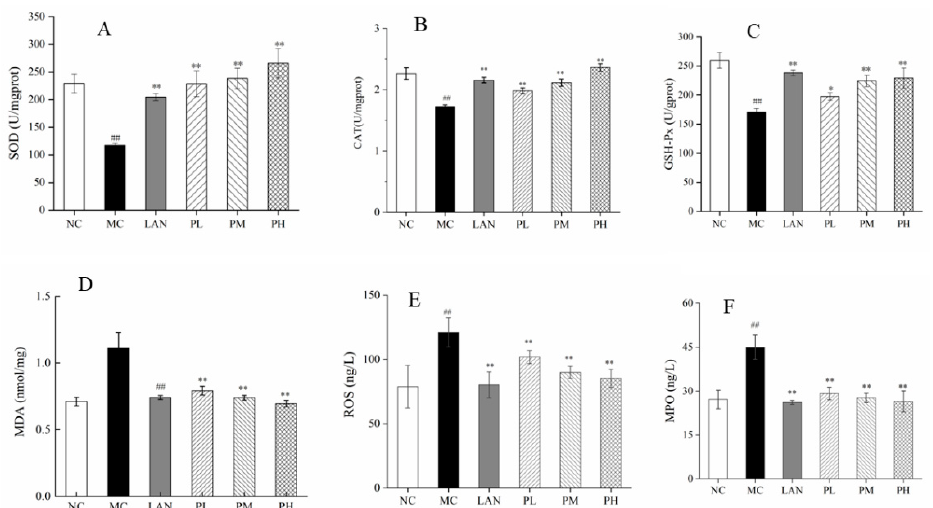
Figure 4. Effect of piperine pretreatment on biochemical indicators in gastric tissue. ( A ) SOD; ( B ) CAT; ( C ) GSH-Px; ( D ) MDA; ( E ) ROS; ( F ) MPO. Ave ± SD, ## p < 0.01 vs. NC group; * p < 0.05 and ** p < 0.01 vs. MC group.